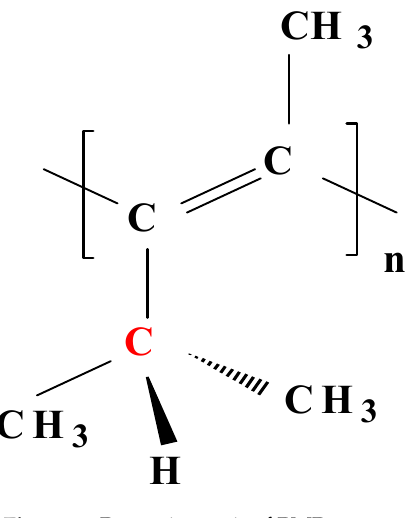
Figure 2. Repeating unit of PMPentyne.